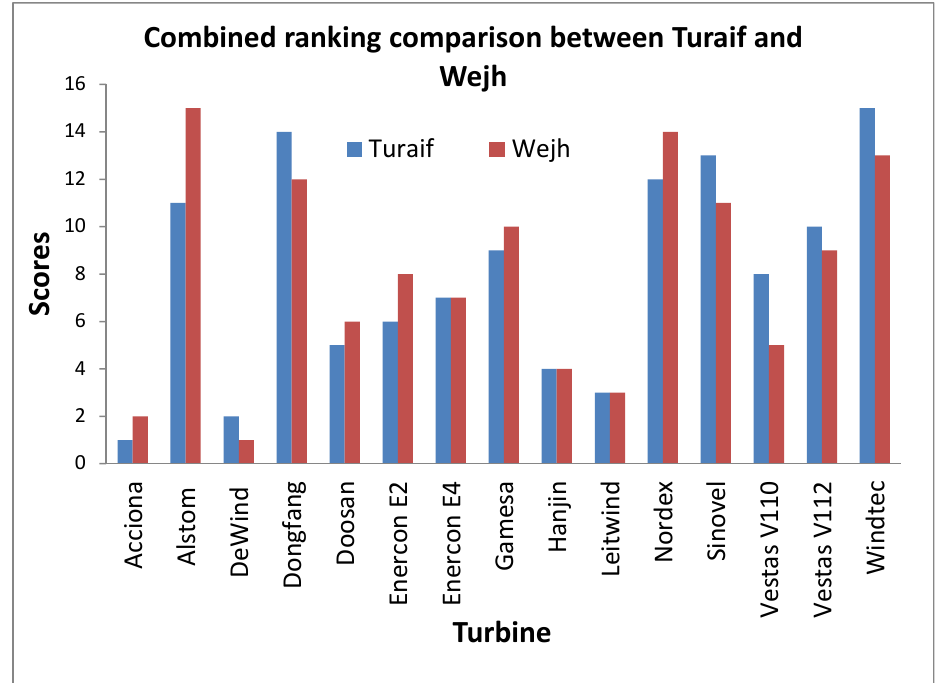
Figure 8. Comparison of scores for different turbines for Turaif and Wejh using all methods